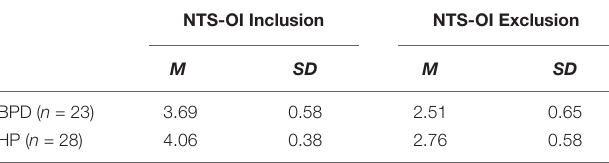
TABLE 3 | Mean and standard deviations of Cyberball NTS-OI inclusion and NTS-OI exclusion for BPD patients and healthy participants